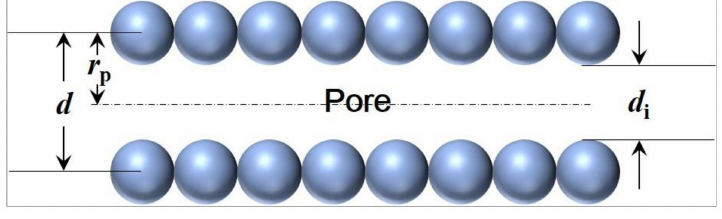
Figure 1. The pore of the silica